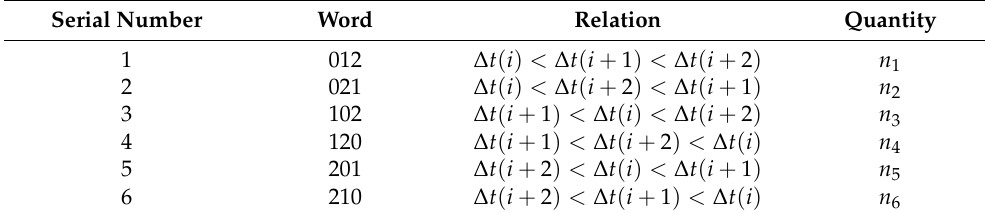
Table 2. Ordinal patterns for D = 3.